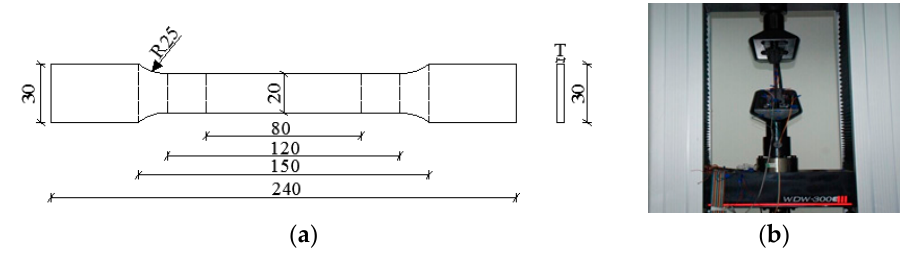
Figure 2. Tensile test of steel coupons. ( a ) Designed size; ( b ) Loading setup.